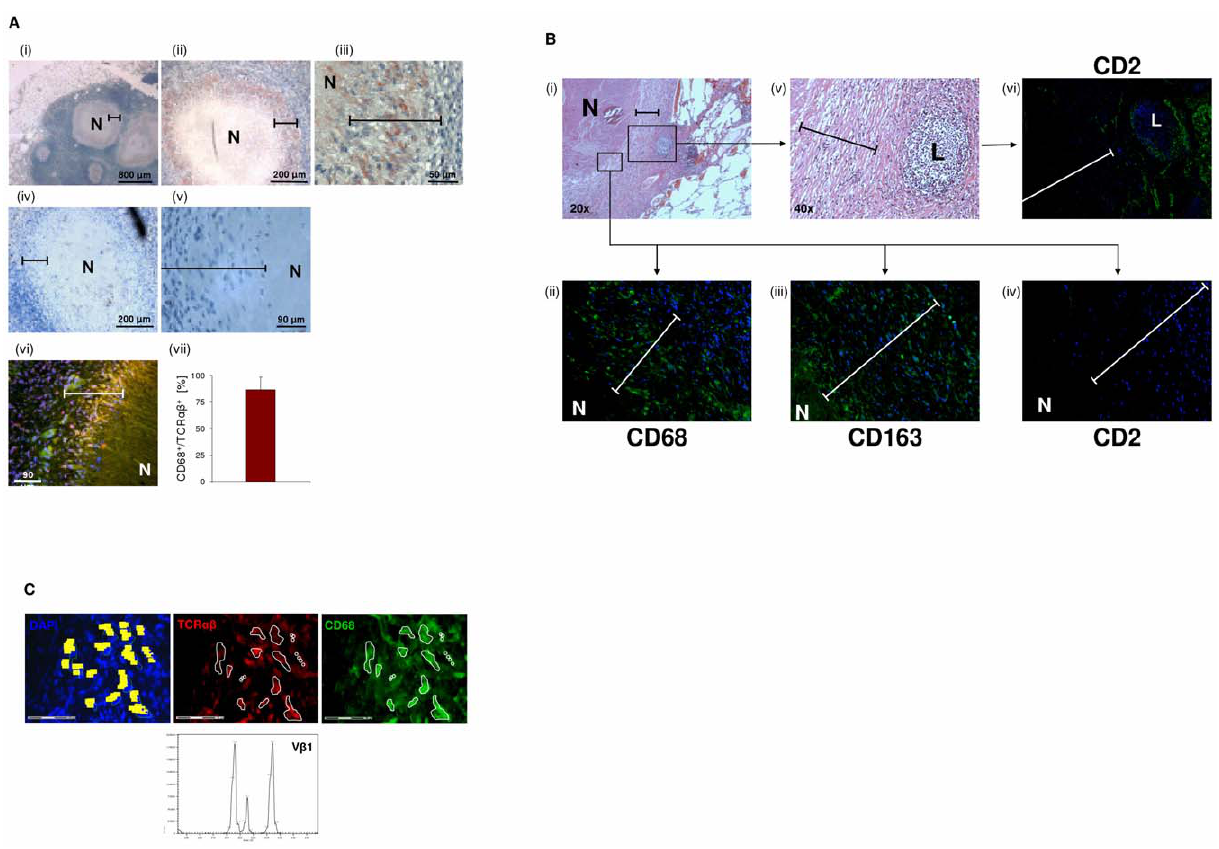
Figure 6. Massive accumulation of TCR ab + macrophages in the inner epithelioid cell corona of human tuberculous granulomas. ( A ) Presence of the macrophage-TCR ab in circumscribed caseous tuberculous granulomas. Light microscopic images i-iii reveal intense red/brown immunostaining for the TCR ab in the inner host-pathogen contact zone (bars) of the granulomas at various magnifications. (iv, v) Staining for CD2. N, necrotic caseous core. The lung sections were obtained from a patient with pulmonary tuberculosis and are representative of 10 out of 13 randomly selected patients (Table S2). Immunofluorescence double-staining for the TCR ab (red) and the macrophage marker CD68 indicates that the TCR ab + cells are macrophages (vi, yellow, merged). (vii) Mean percentage of CD68 + /TCR ab + cells in the inner epithelioid cell corona of circumscribed caseous tuberculous granulomas from 8 different patients. Percentages of double positive cells in this zone (CD68 + /TCR ab + cells : total number of nuclei) were determined from three sections of each patient. ( B ) Single immunostaining for the markers CD68 and CD163 demonstrates that macrophages represent the vast majority of cells in the epithelioid cell corona of the caseous tuberculous granulomas (i–iii). Staining for CD2 reveals that T cells and natural killer cells are predominantly located in the outer segment of the corona (iv). A focal accumulation of lymphocytes (L) located in the peripheral corona zone is shown in the right box (i,v). Note positive staining for CD2 (vi). Bars in all images span the inner host-pathogen contact zone. N, necrotic core. Isotype controls are shown in Figure S5A. ii–iv,vi: 40x. ( C ) Laser microdissection of a 20–30 cell cluster of CD68 + /TCR ab + double-immunostained macrophages (encircled) from the inner host-pathogen contact zone of a caseous tuberculous granuloma. TCR ab + , red; CD68 + , green; scale bar, 75 m m. Dissected cells are highlighted in yellow (left). Ex situ V b CDR3 spectratype analysis of the excised cells reveals expression of restricted TCR V b 1 repertoires.